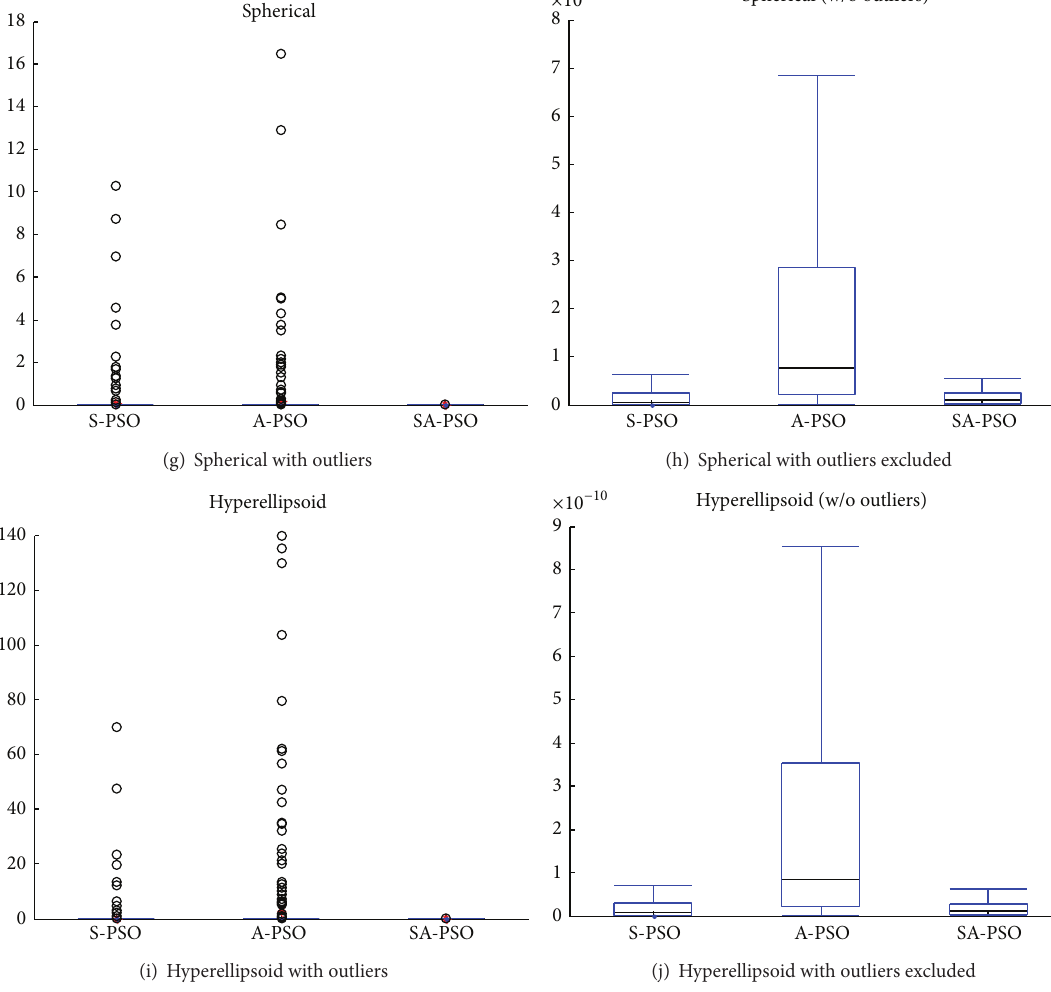
Figure 4: Results of experiments on unimodal functions.